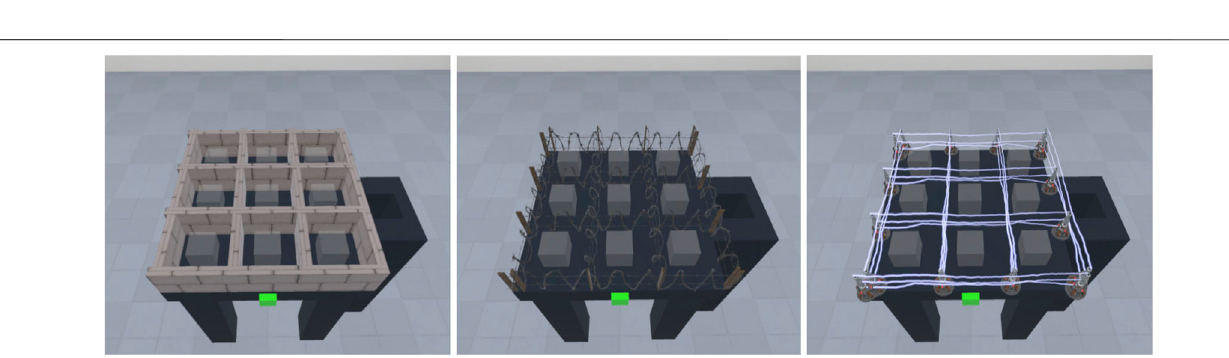
(cid:129) the Barbed Wire obstacle condition ( Figure 4B ), which is both threatening and solid; and (cid:129) the Electric Current obstacle condition ( Figure 4C ), which is threatening but not solid.